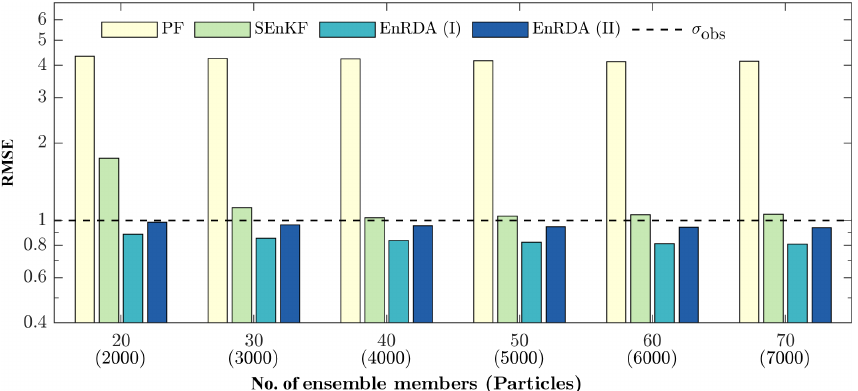
Figure 5. The RMSE for the different number of ensemble members/particles in the PF, SEnKF, and EnRDA when the displacement param- eter is obtained from bias-aware cross-validation (ENRDA-I) and a dynamic approach without a priori knowledge of bias (EnRDA-II) for the Lorenz-96 system. The dashed line is the standard deviation of the observation